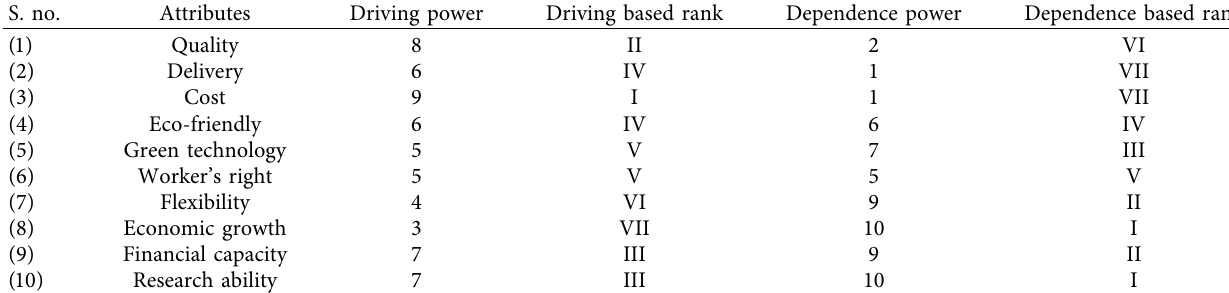
Table 6: Powers-based ranking of attributes.